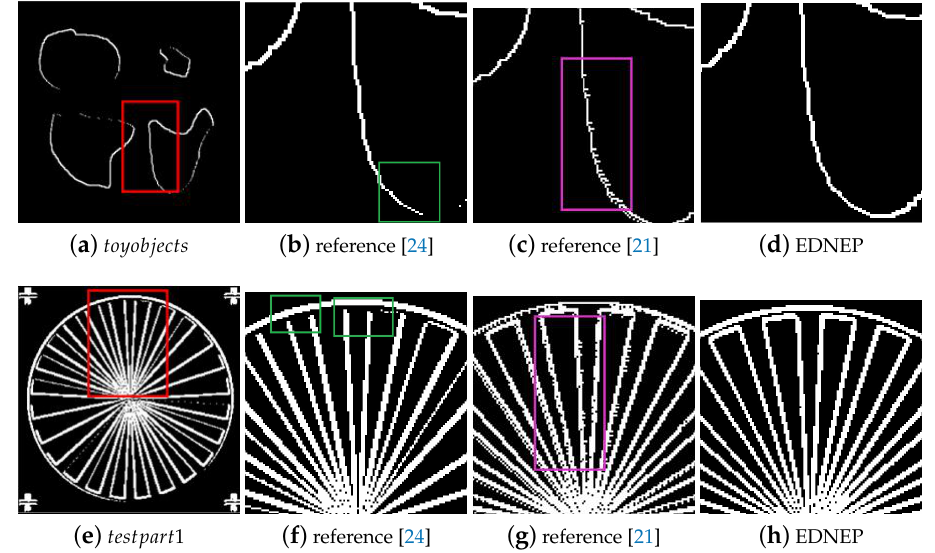
Figure 5. Edge detection results of toyobjects and testpart 1 (the first column: the edge image; the second to the last columns: the local edge image enlarged by using methods in [21,24] and EDENP